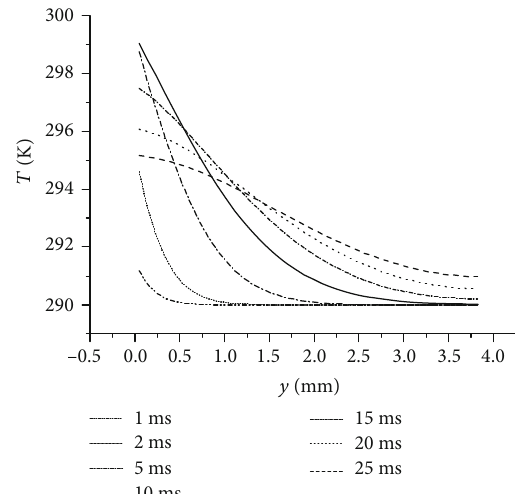
Figure 13: Temperature distribution in the